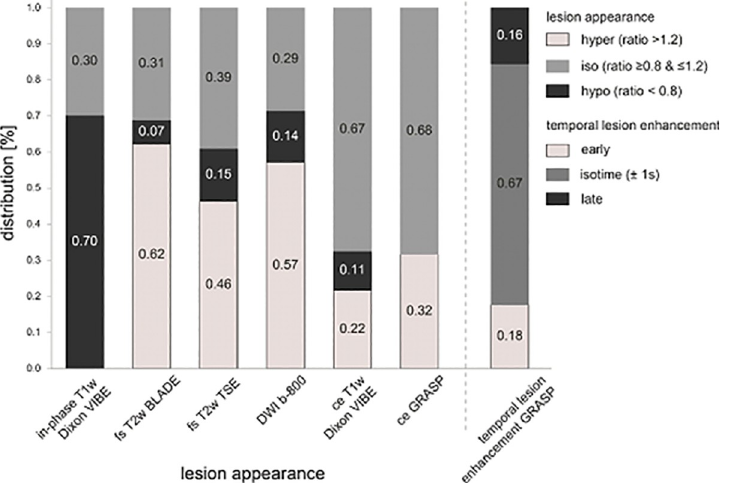
Fig 6. Distribution of signal characteristics of PICTs. This figure shows the distribution of signal characteristics in T1w in-phase, Fs T2w BLADE, fs T2w TSE, DWI b-800, ceT1w Dixon VIBE, ce GRASP and temporal lesion enhancement GRASP based on Tumor-to-background ratio (T2B) T2B ratios for each sequence. PICTs with a T2B ratio of < 0.8 = hypointense relative, T2B ratio of > 1.2 = hyperintense, T2B ratio ranging from 0.8–1.2 = isointense relative to normal parenchyma. The bar chart on the left depicts temporal PICT enhancement characteristics on ce GRASP sequence. Temporal enhancement was defined as early < -1 seconds, isotime between -1 and + 1 seconds and late as > +1 seconds comparing the time of maximum enhancement of the PICT to the normal